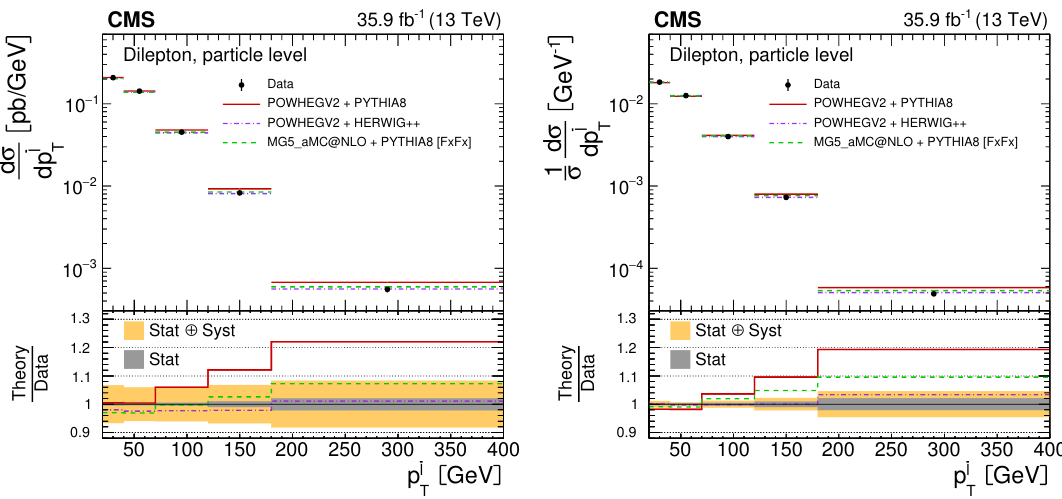
Figure 34 . The di(cid:11)erential tt production cross sections as a function of p (cid:22) ‘ at the particle level are shown for the data (points) and the MC predictions (lines). The vertical lines on the points indicate the total uncertainty in the data. The left and right plots correspond to absolute and normalised measurements, respectively. The lower panel in each plot shows the ratios of the theoretical predictions to the data. The dark and light bands show the relative statistical and total uncertainties in the data,